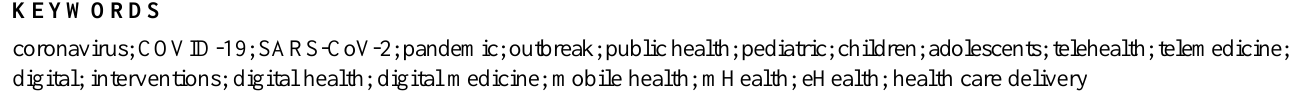
coronavirus; COVID-19; SARS-CoV-2; pandemic; outbreak; public health; pediatric; children; adolescents; telehealth;